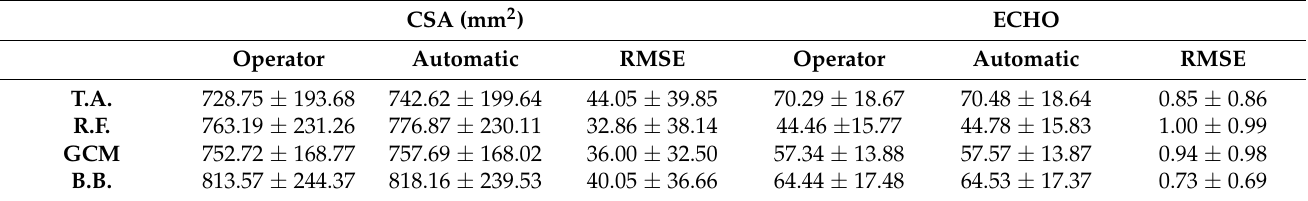
muscle, the average discrepancy is presented in terms of RMSE. Table 4. Comparison results between the manual and automatic CSA measurements per